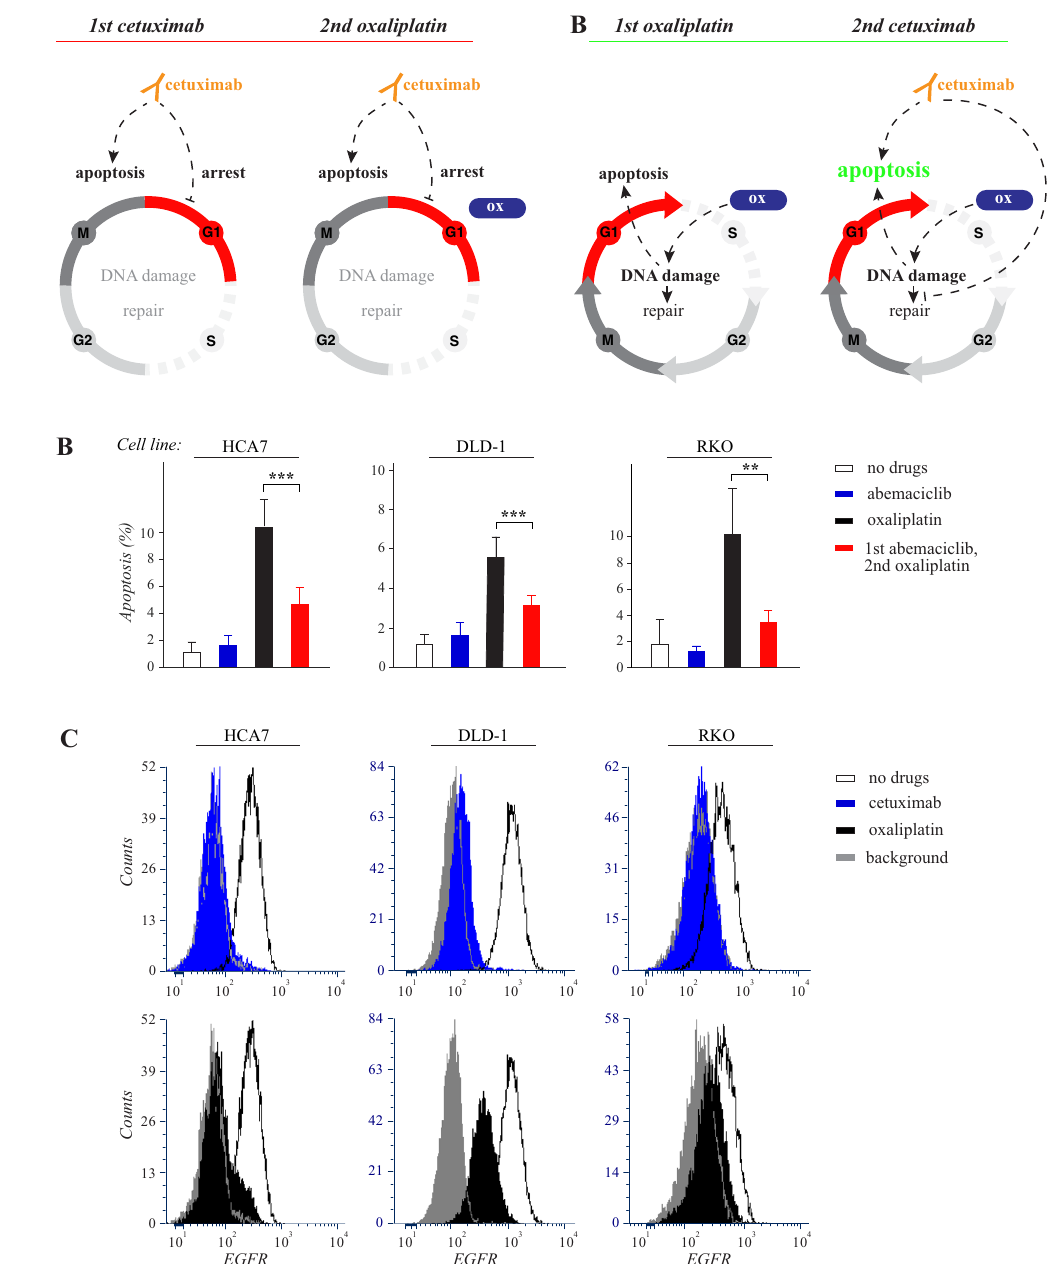
Figure 5. Oxaliplatin is less efficient in G1-arrested cells but induces EGFR downregulation. ( A ) Schematic representation of hypothetical cellular responses to the opposite sequences of cetuximab and oxaliplatin. Left side : When cetuximab is administered first, it promotes arrest in the G1 phase of the cell cycle and stimulates apoptosis by blocking EGFR-activated survival pathways. The subsequent administration of oxaliplatin (ox) is largely ineffective due to the G1-arrest. Right side : When oxaliplatin is administered first, it actively induces DNA damage provoking apoptosis, as well as DNA repair that partially compensates for the damage. In the absence of cetuximab, the cell cycle is not arrested at G1 allowing for full activity of oxaliplatin. However, oxaliplatin-induced DNA damage itself does eventually cause cell cycle arrest by activating checkpoints in the S and G2 phases (not indicated in the figure). When cetuximab is then added after oxaliplatin, apoptosis is enhanced compared to all other regimens, as the apoptotic effect of both drugs are active, and also, as cetuximab may be suppressing the DNA repair mechanisms caused by oxaliplatin-induced DNA damage. ( B ) HCA7, DLD-1 and RKO cells were arrested in G1 by 8 hour treatment with or without 3 µ M of the CDK4/6 inhibitor abemaciclib followed by 18 hour treatment with or without 50 μ M oxaliplatin. Apoptosis was measured by annexin V analysis. Mean + / − SD is shown for three independent experiments. ** P < 0.01; *** P < 0.001. ( C ) Flow cytometry analysis of cell surface EGFR after 24 hour treatment with or without 10 μ g/ml cetuximab or 50 μ M